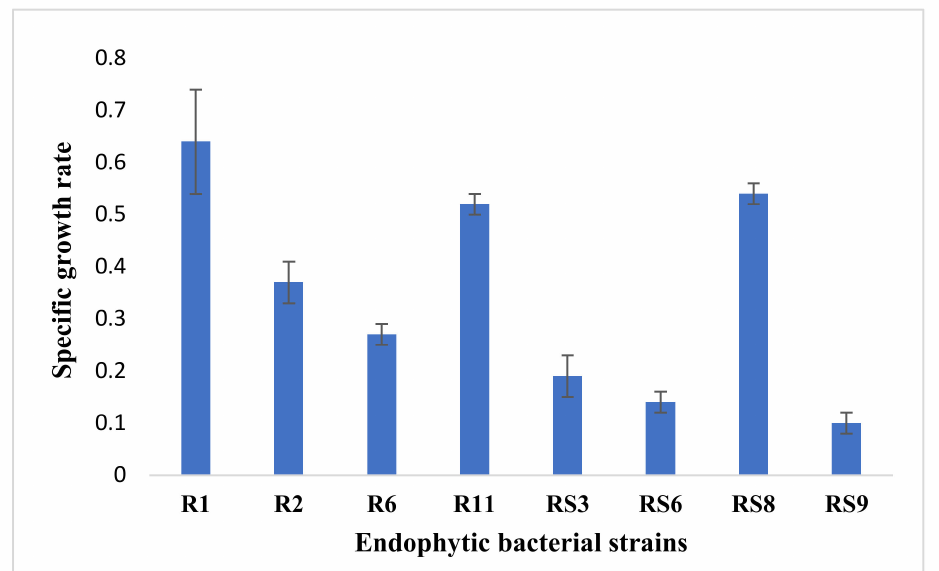
Figure 3. Specific growth rate (h − 1 ) of the endophytic isolates grown in LB broth. The values represent ±